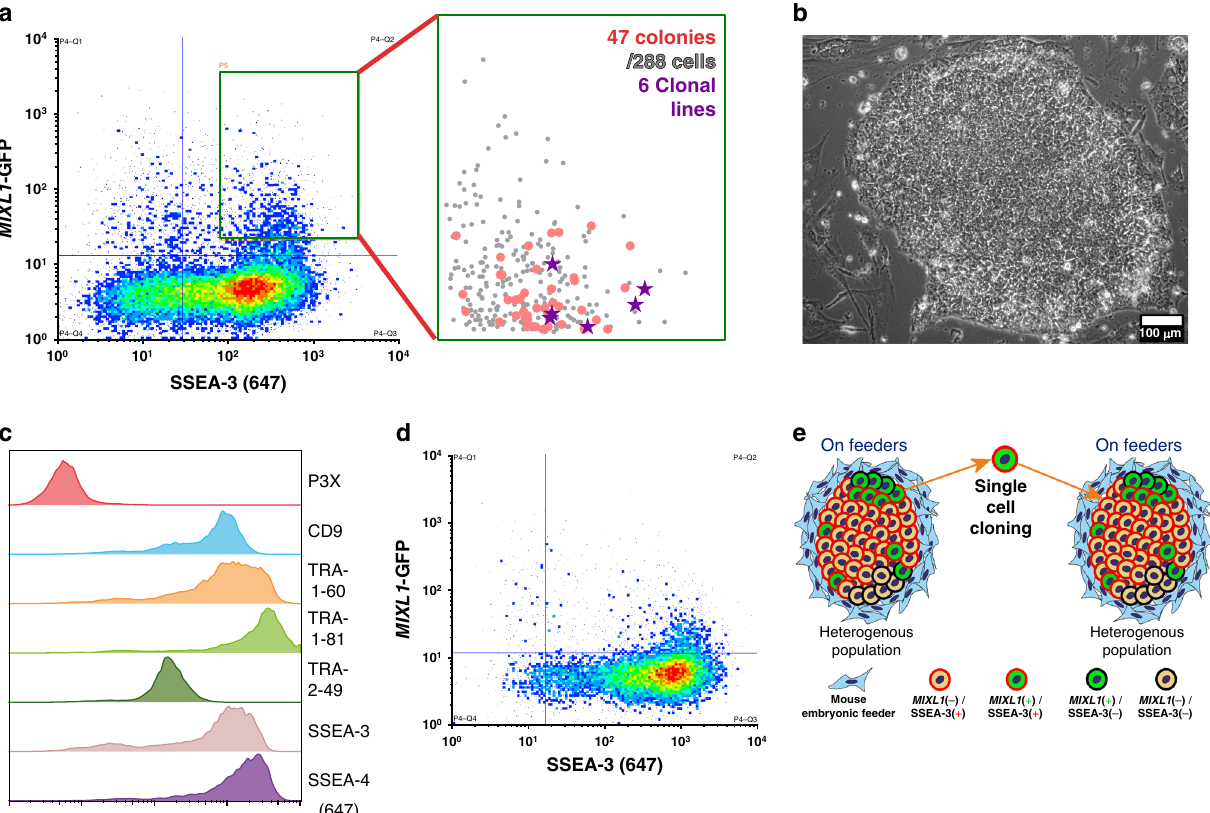
Fig. 2 The MIXL1 -GFP/SSEA-3 positive state contains a self-renewing stem cell. a Density dot plot of MIXL1 -GFP expression against the surface marker SSEA-3 expression from cells growing in MEF/KOSR conditions. The green gate indicated was used to specify the MIXL1 /SSEA-3 double positive fraction and cells from this region were sorted into three 96 well plates. The zoomed in scatter plot shows the indexed positions of the 47 isolated cells that formed colonies (red circles), including 6 that were selected randomly to generate clonal lines (purple stars) from 288 sorted cells (grey circles), a cloning ef fi ciency of ~16%. Source data are provided as a Source Data fi le. b Phase contrast image of a typical HES3 MIXL1 -GFP clone (Clone 2-D2, one of 47 colonies identi fi ed) growing in MEF/KOSR conditions (scale bar = 100 µ M). c Flow cytometry histograms of one of six clonal lines, clone 2-D2, for